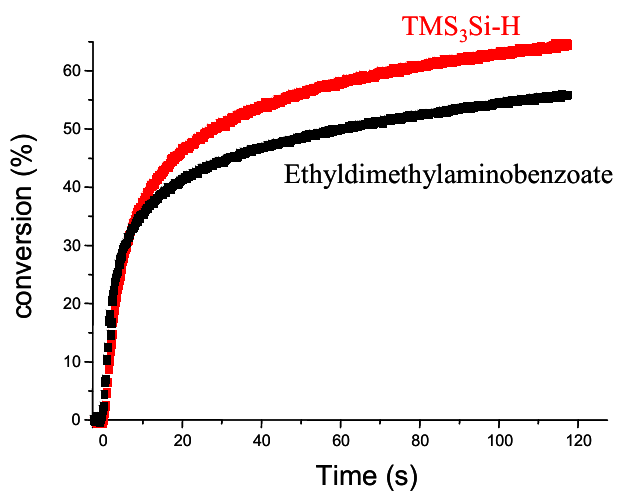
Figure 1. Polymerization profiles of trimethylolpropane triacrylate. Benzophenone/ (TMS) SiH (1%/2%) vs. benzophenone/ethyldimethylaminobenzoate (1%/2%) in 3